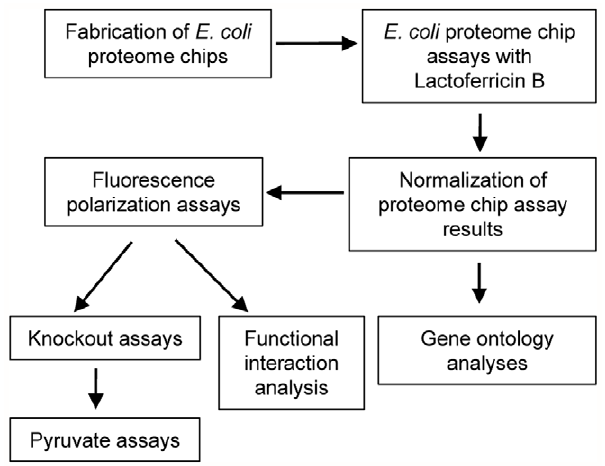
Figure 1. Scheme for the identification of intracellular targets of LfcinB. We used a high-throughput protein purification protocol to purify , 4,300 E. coli proteins. These proteins were printed onto Fullmoon slides to fabricate E. coli proteome chips. We then probed LfcinB with E. coli proteome chips and analyzed the chip assay results by bioinformatics analyses. FP assays were then used to validate the identified proteins and 16 proteins were confirmed to be bound to LfcinB. We conducted knockout assays to further validate the 16 proteins and the EcID was used to observe the functional interactions of these 16 proteins. The knockout assay results revealed that one of the mechanisms of LfcinB action was associated with pyruvate metabolism. Finally, we used pyruvate assays to observe the relationship between LfcinB and pyruvate.